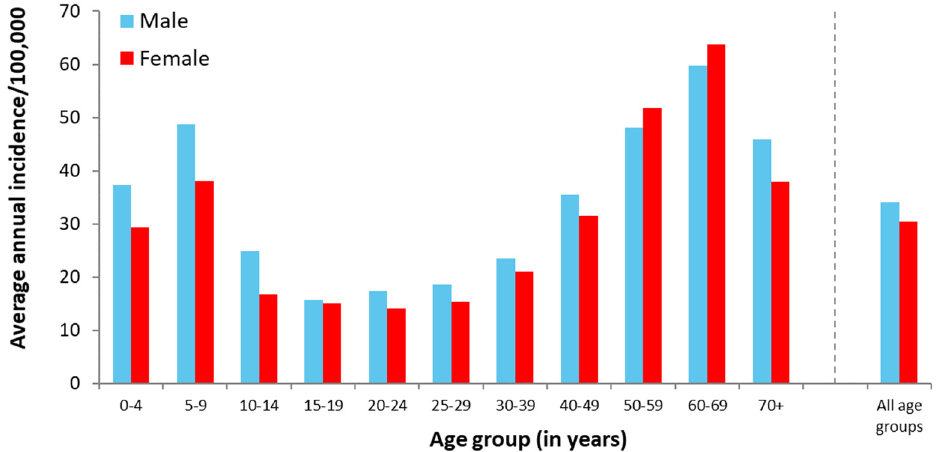
Figure 1. Average annual incidence (reported cases per 100,000 inhabitants) of LB in Bavaria, Germany, during 2013–2020 by age group and sex ( n =34,002 with information on age and sex availa- ble).